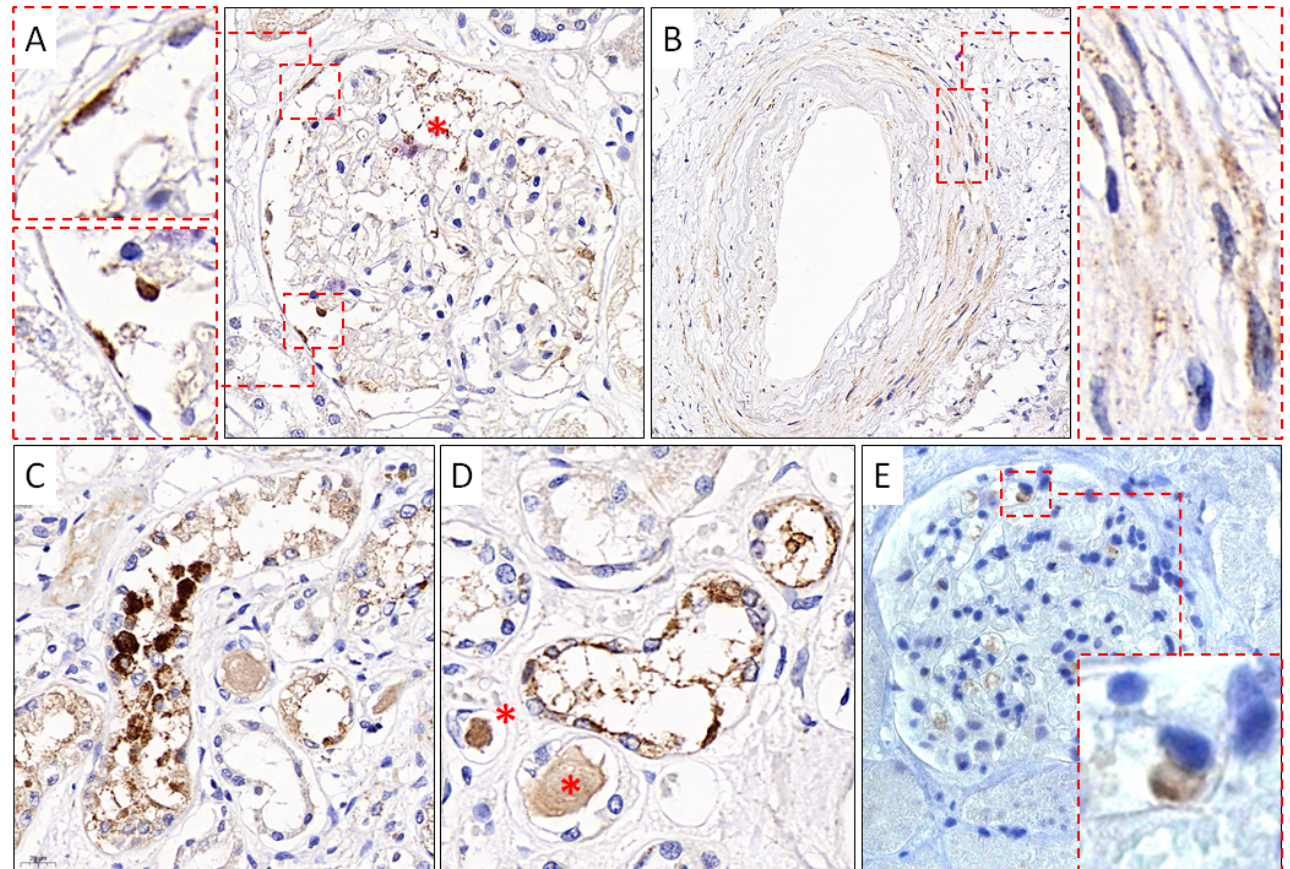
Figure 5. Results of IHC study using mAb against SARS ‐ CoV ‐ 2 S ‐ protein. ( A ). SARS ‐ CoV ‐ 2–positive staining of endothelial cells, cells of the capillary network (red asterisk), and parietal epithelial cells (red frames) of the capsule of the renal glomeruli, GeneTex, ×400; ( B ). Immunoreactive smooth muscle cells (red frame) of the vascular wall of the kidneys, GeneTex, ×400; ( C , D ). Positive staining of cells of the convoluted tubules of the kidneys and homogeneous protein content in the lumen of the tubules (red asterisks), GeneTex, ×400; ( E ). Positive staining of the renal glomeruli capillary network cells (red frame), Abcam, ×400.